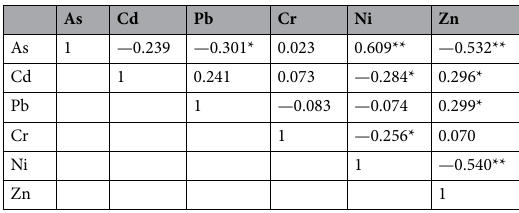
Table 3. The relationship between heavy metals in the examined tissue of pheasants in total (N = 64). *Values statistically significant P < 0.05. **Values statistically significant P < 0.01.